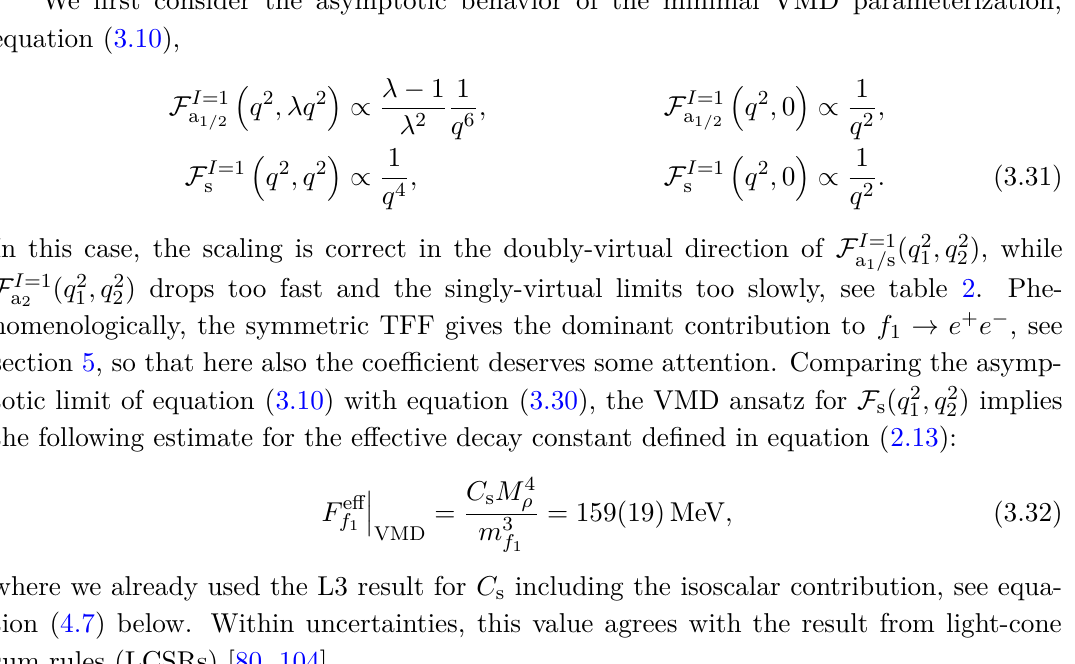
( w ) and f s ( w ) , equation (3.29), with values for the limiting 2 , and q 2 = 0 = 0 , q 2 = q 2 1 1 2 2